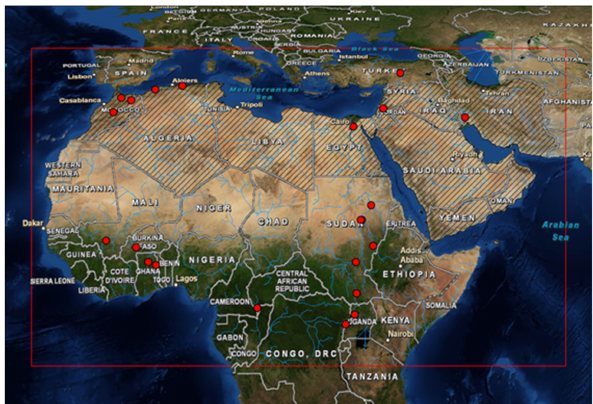
Fig. 1. Spatial domain of the hydrological model (red box). MENA countries are shaded. Red dots show the location of the GRDC sta- tions used for